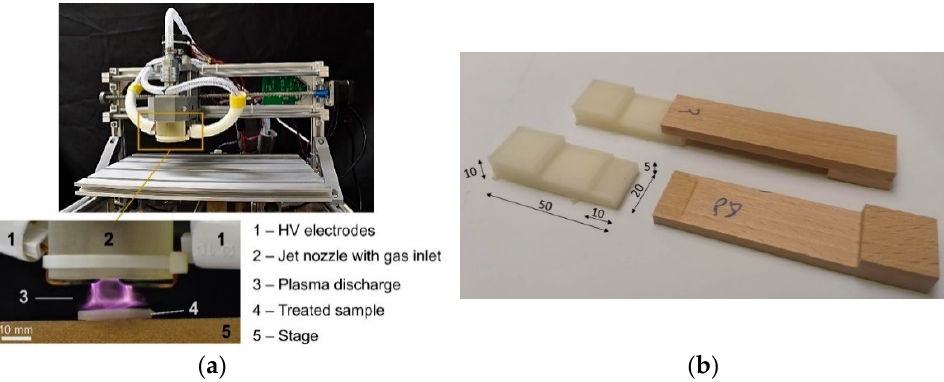
Figure 1. Plasma device used for the surface treatment of 3D-printed samples on a CNC positioning system (top left image) with a gliding arc plasma jet ( a ), and sample for testing the bond shear strength ( b ).